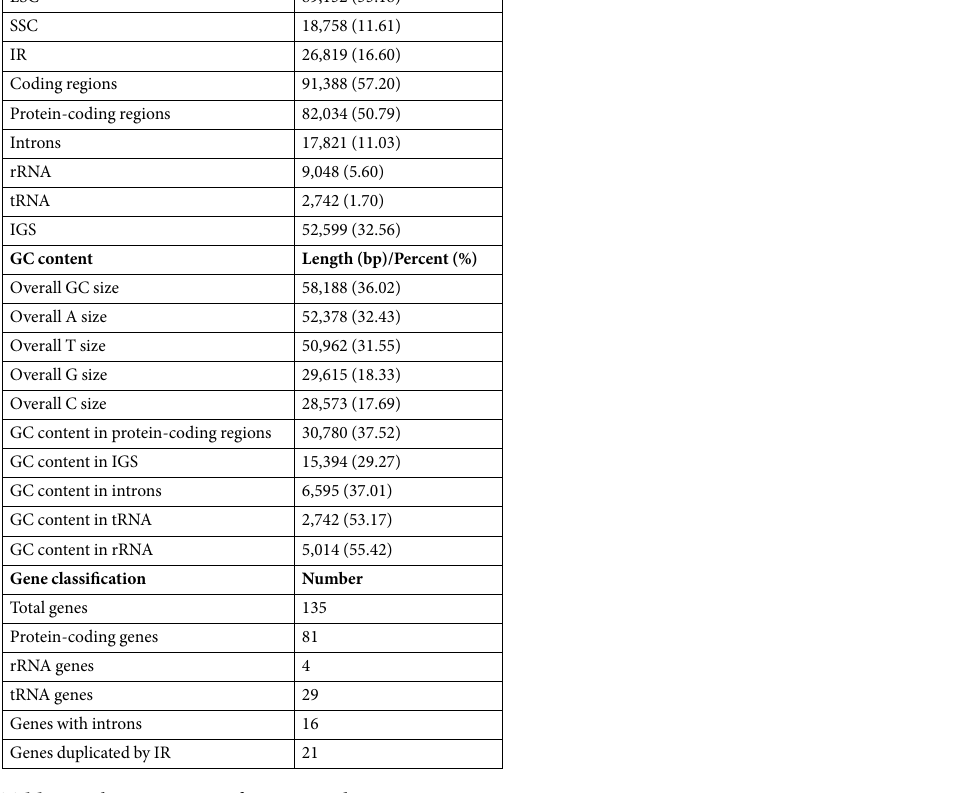
Table 1. Characteristics of tung tree plastome